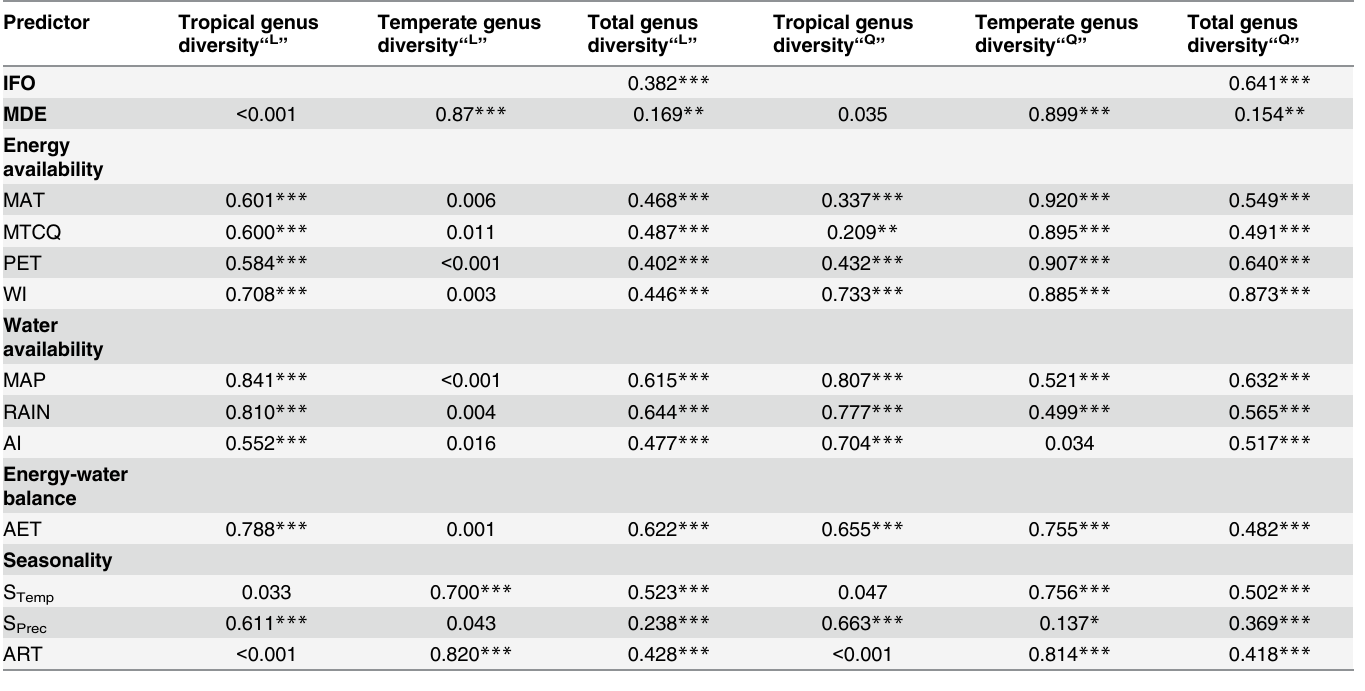
Table 1. Coefficients of determination ( R 2 ) for each predictor in simultaneous autoregressive regressions in linear and quadratic forms.